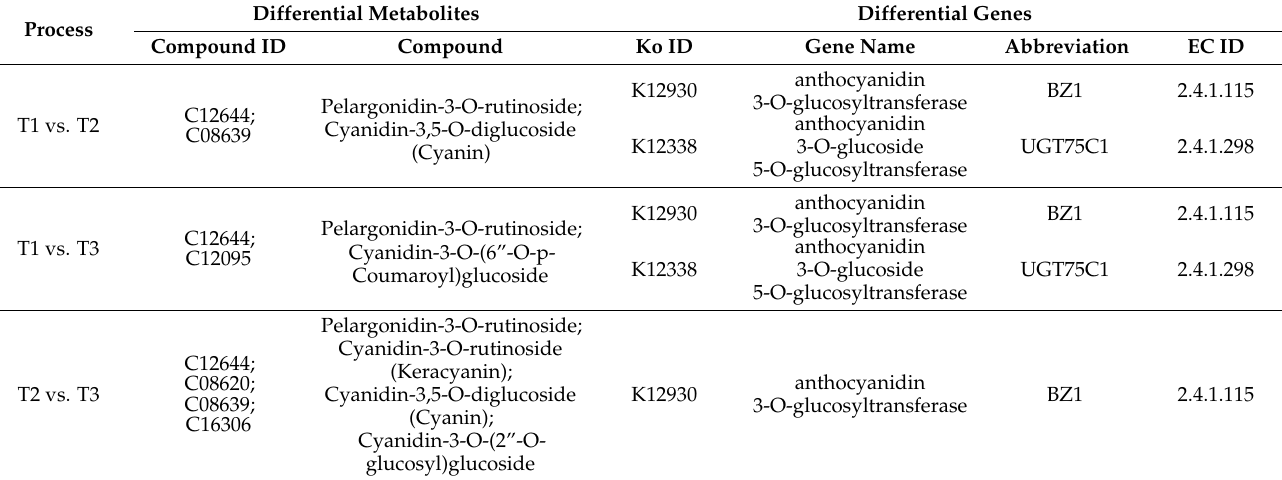
Figure 8. ( a ) Cluster heatmap of correlation between differentially accumulated metabolites (DAMs) and differentially expressed genes (DEGs) at T1 vs. T2, T1 vs. T3, and T2 vs. T3 comparison groups. The abscissa represents the DAMs, the ordinate represents the DEGs. ( b ) Combined transcriptome and metabolome analysis of correlation network patterns in T1 vs. T2, T1 vs. T3, and T2 vs. T3 comparison groups. Table 1. Differential metabolites and genes in the flavonoid biosynthetic pathway.